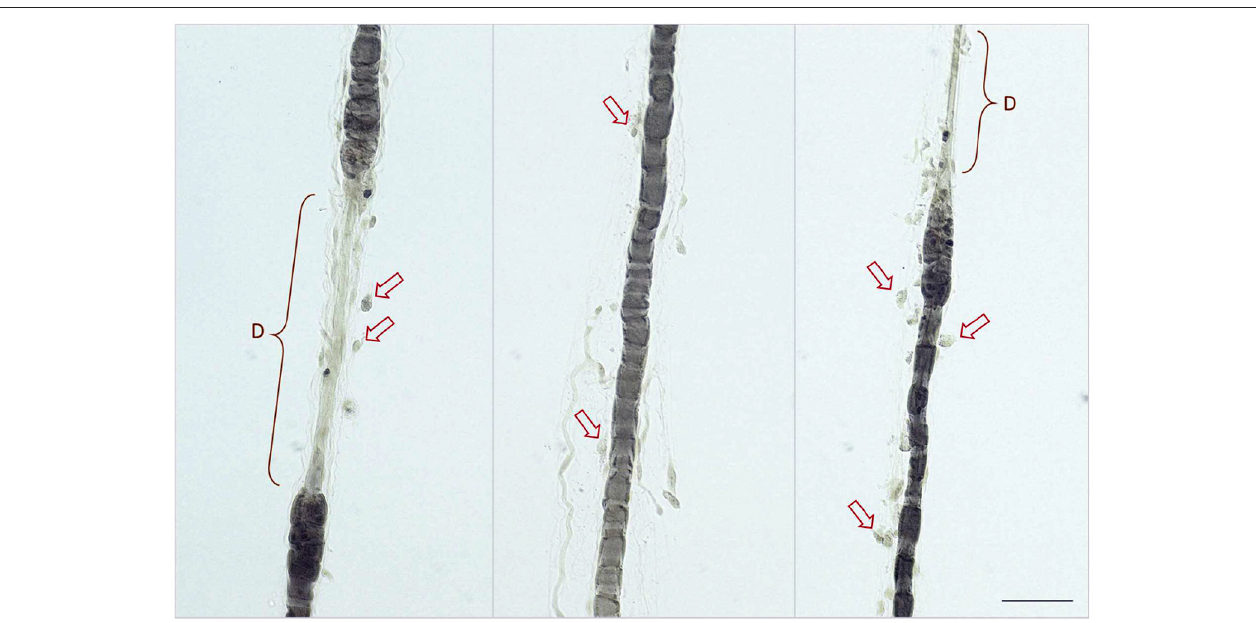
FIGURE 1 | Nerve fiber teasing preparations showing multiple fiber adhesive and invasive round mononuclear cells (lymphocytes and macrophages) indicated by red arrows at the Schmidt Lanterman clefts, paranodium and along demyelinated segments (indicated by D). Biopsy of the peroneal nerve contrasted with Osmium tetraoxide, scale bar 50 µ m.